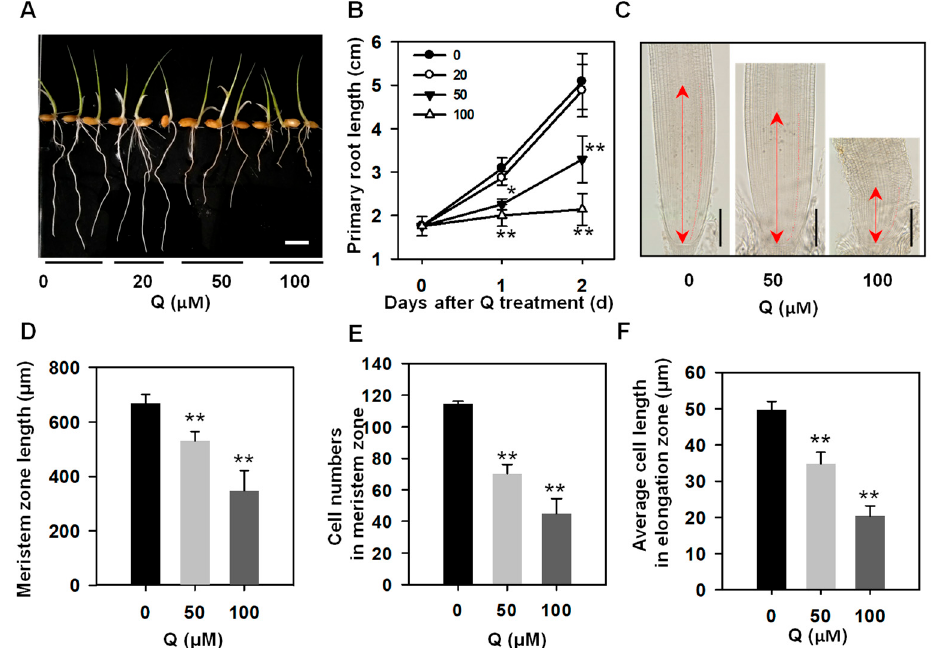
Figure 1. The effect of quercetin on rice root growth. ( A ) The rice root growth phenotype with 0, 20, 50, or 100 μ M of quercetin (Q) treatment. Photos were taken after treatment with different concentration of quercetin for two days. Bar = 1 cm. ( B ) Time course of the primary root length of the rice seedlings treated with quercetin. Values are means ± standard deviation (SD; n = 60). The asterisks indicate a significant difference between the control and quercetin-treated plants at an indicated time (Student’s t test, * p < 0.05, ** p < 0.01). ( C ) Size of the root meristem with 0, 50, or 100 μ M of quercetin treatment for two days. Double-headed arrow indicates the meristem zone. Bars = 200 μ M. ( D ) The meristem zone length with 0, 50, or 100 μ M quercetin treatment for two days. Values are means ± SD ( n = 10). ( E ) The cell numbers in the meristem zone with 0, 50, or 100 μ M quercetin treatment for two days. Values are means ± SD ( n = 10). ( F ) Average cell length in the elongation zone with 0, 50, or 100 μ M quercetin treatment for two days. Values are means ± SD ( n = 10). The asterisks in ( D , E , F ) indicate a significant difference between the control and quercetin-treated plants (Student’s t test, ** p < 0.01).